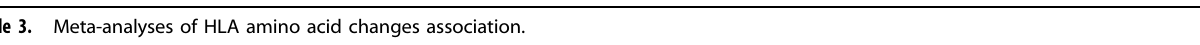
Table 3. Meta-analyses of HLA amino acid changes association. Amino